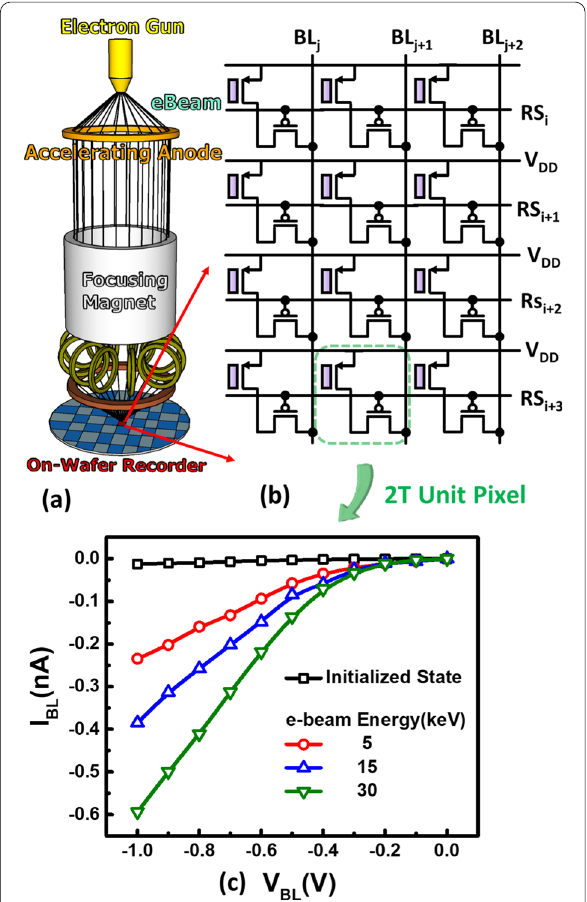
Fig. 1 a The experimental setup and b schematic of the proposed e‑beam detectors array, start with in‑chamber detection, on‑wafer off‑line readout and intensity image reconstructed by c its electrical characteristics measurement